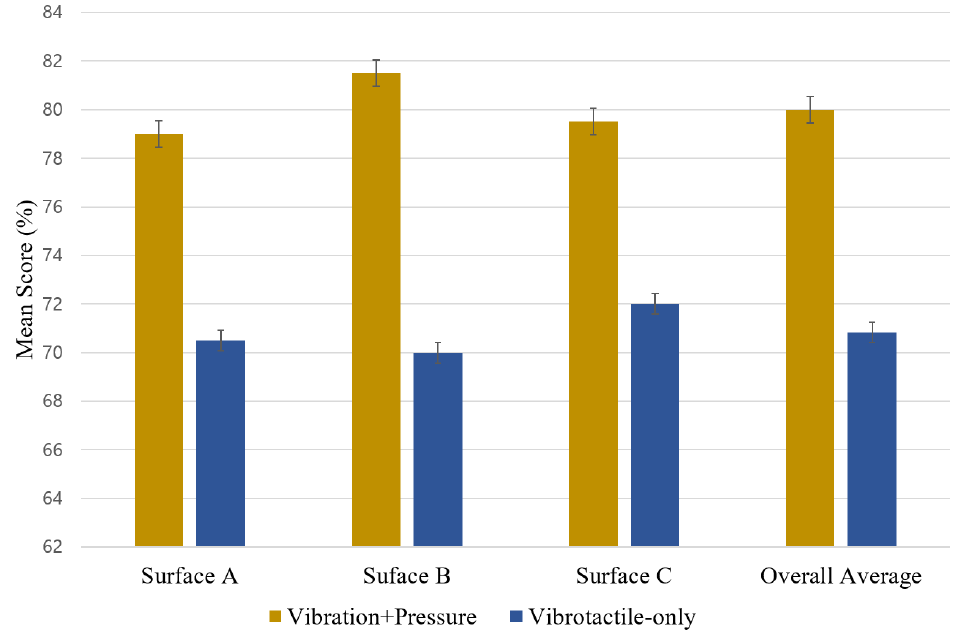
Figure 13. Mean scores for the realism. The error bars show the standard